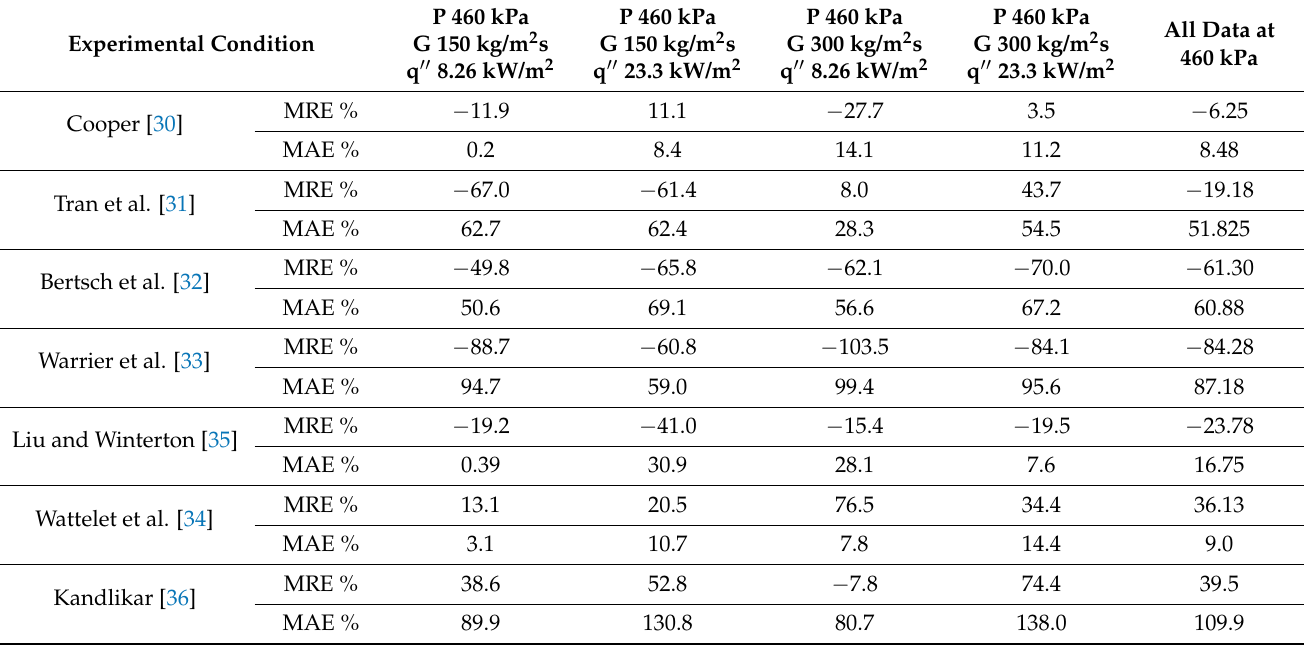
Table 6. Statistical analysis of the comparison between experimental heat transfer coefficient and prediction models at saturation pressure of 460